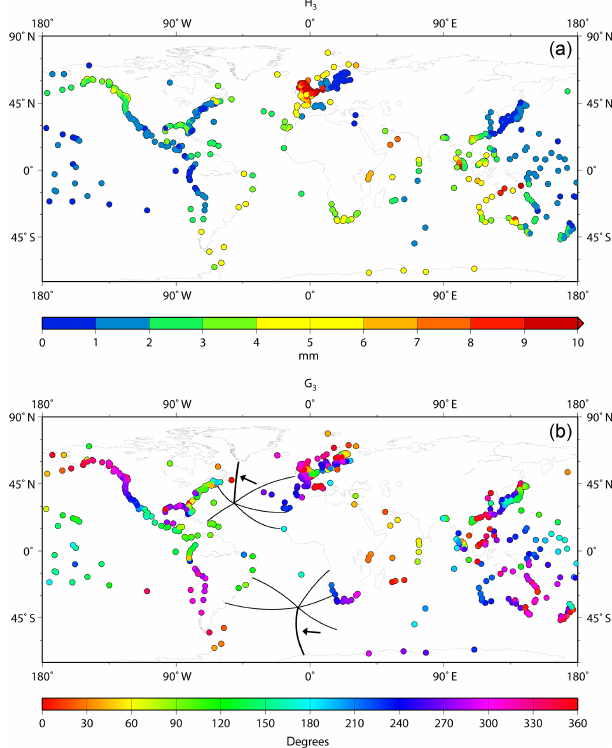
Figure 7. (a) Amplitude and (b) Greenwich phase lag of M1 at stations in the GESLA-2 data set. Panel (b) includes the co-tidal lines from the Platzman synthesis for M1 shown in Fig.